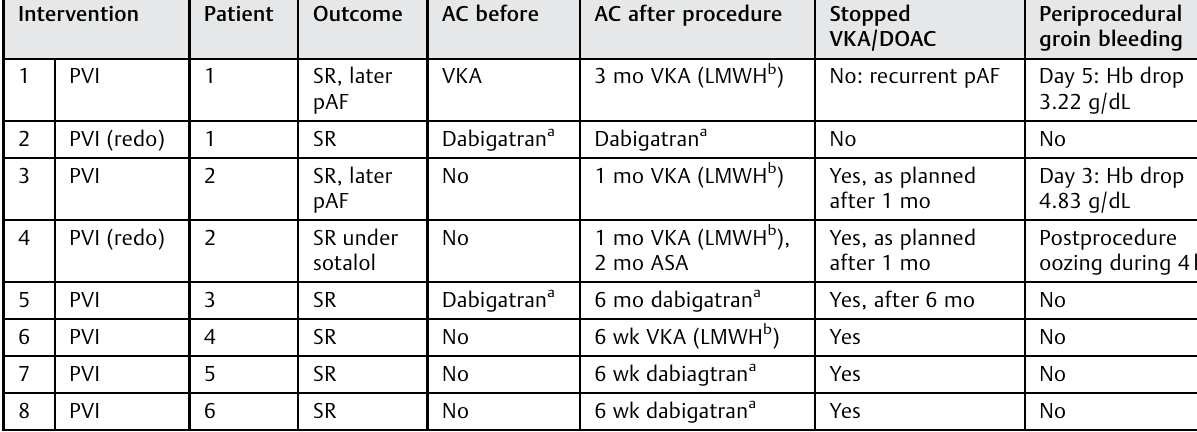
Table 2 Interventions — outcome and complications Intervention